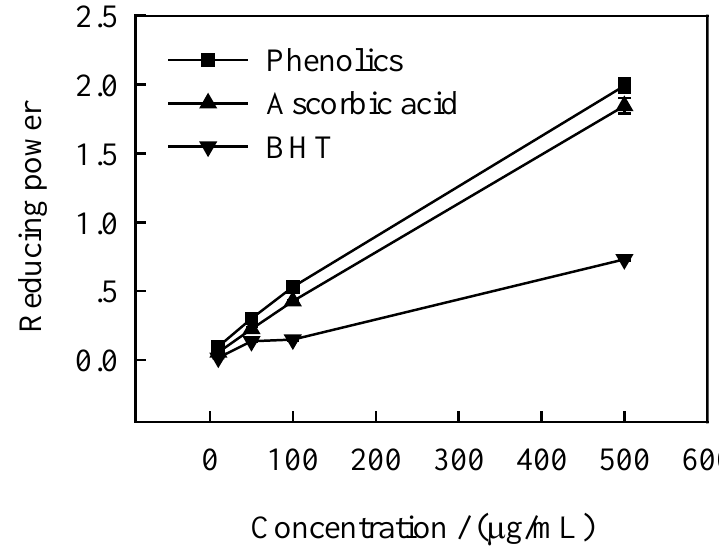
Figure 3 . Reducing power of phenolics from litchi pericarp